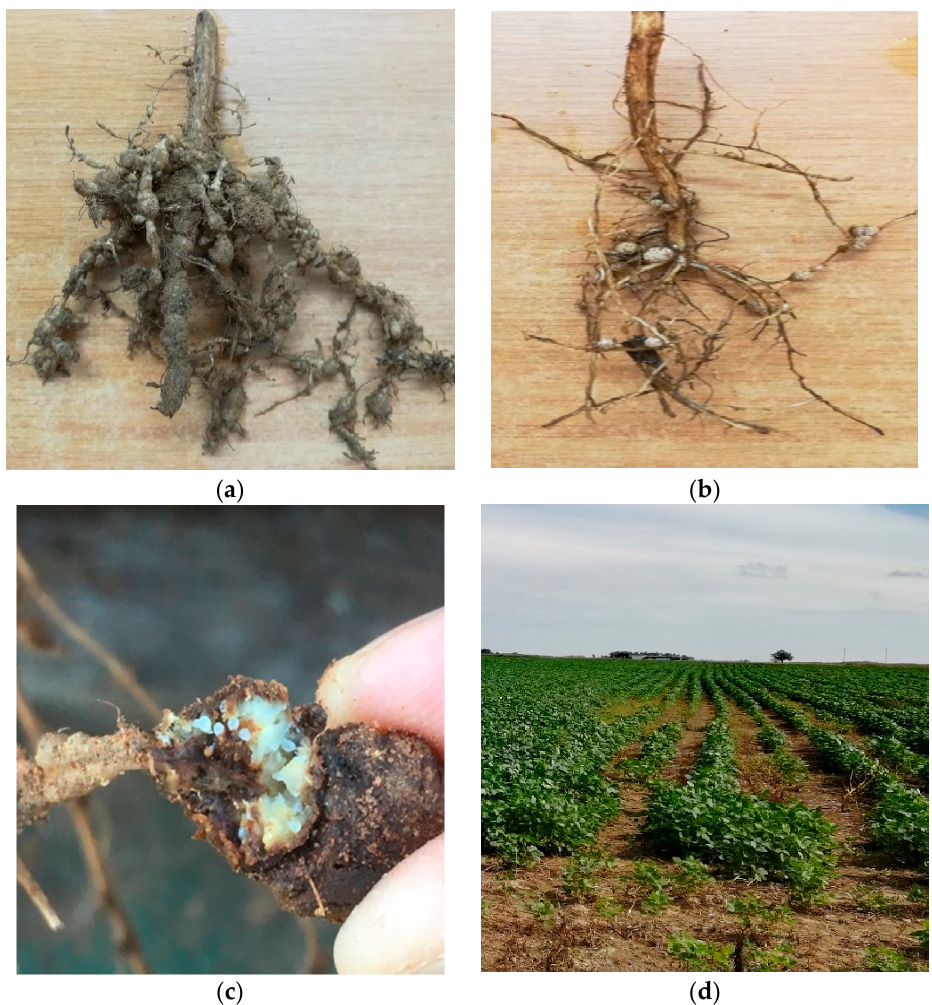
Figure 1. ( a ) Heavily infected and galled root, ( b )healthy soybean root with no root-knot nematode galls visible and with nitrogen-fixing nodules , ( c ) Meloidogyne females found in nitrogen-fixing nodules, and ( d ) stunted growth of soybean plants infected with root-knot nematodes. Photos by: ( a , b , d ) G. Engelbrecht, North-West University, Potchefstroom and ( c ) by Suria Bekker, Econemaria,